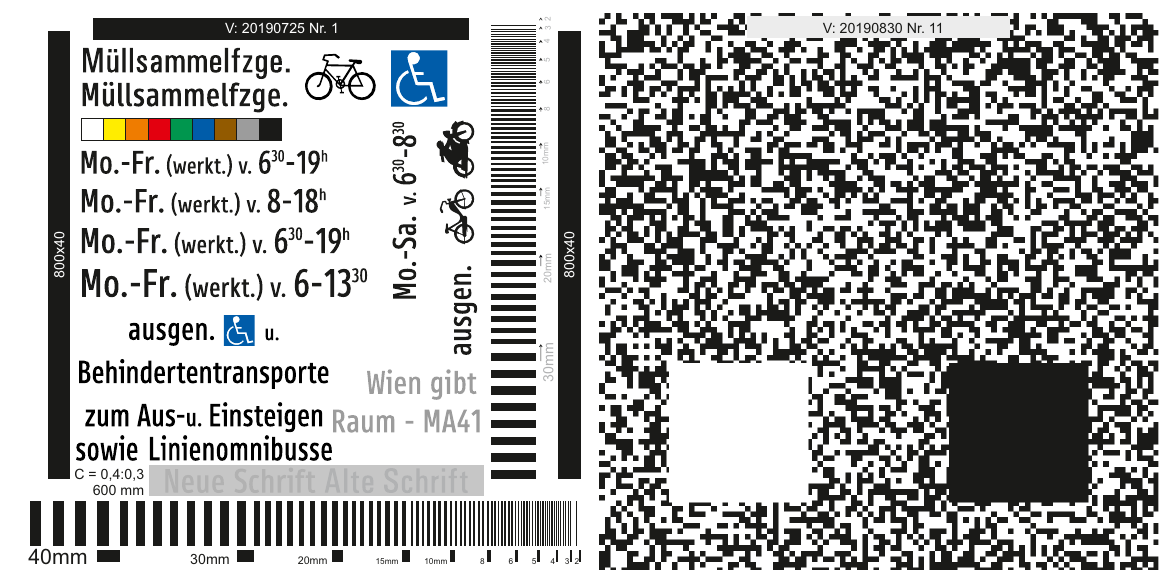
Figure 2. Test charts for assessing imaging quality ( left ) and point distribution ( right ) in mobile mapping applications. These specific test charts were developed with the Municipal Department “Surveying and Mapping” (MA 41)—City of Vienna, and thus the text is in German, font size and shape are taken from street signs in Vienna, as are the symbols and colors used. The charts have a size of 1m × 1m